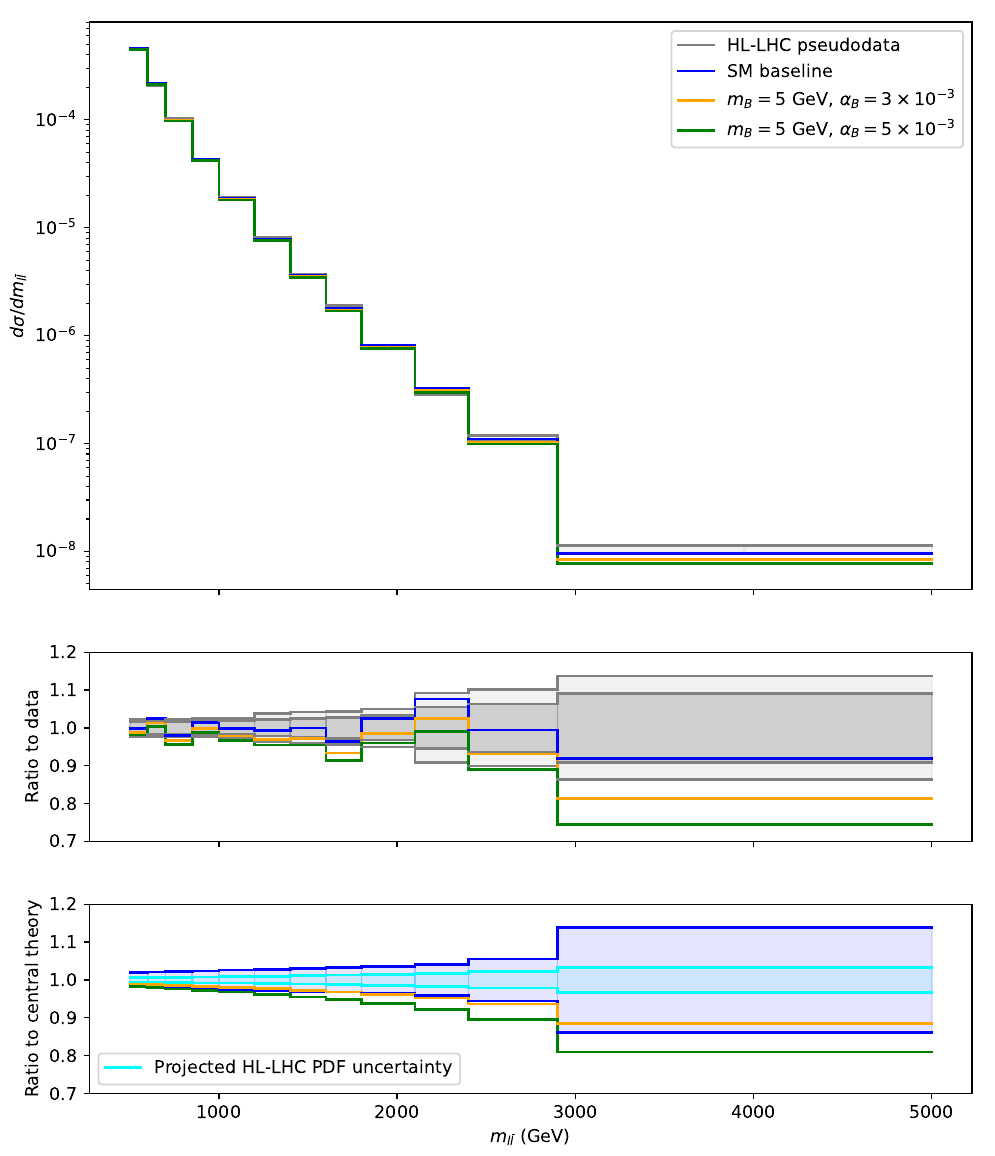
Figure 6 . Top: data-theory comparison between HL-LHC pseudodata in the electron channel generated according to eq. (3.7) (grey, with optimistic uncertainties displayed), and the theoretical predictions obtained using the NNLO baseline PDF set NNPDF3.1luxQED (blue) and those obtained using the dark PDF sets produced with parameters ( m ) = (5 GeV , 3 × 10 − 3 ) , (5 GeV , 5 × 10 − 3 ) B , α B (yellow, green respectively). Middle: ratio of the baseline SM central predictions obtained using the baseline, and the central predictions obtained using the two representative dark PDF sets, to the central values of the pseudodata. The relative experimental uncertainties in both the optimistic scenario (dark grey) and conservative scenario (light grey) are displayed. Bottom: ratio of the central predictions obtained using the two representative dark PDF sets to the baseline SM central predictions, with both the PDF uncertainty from the baseline PDF set (dark blue) and the projected PDF uncertainty at the HL-LHC in the optimistic scenario of [43] (light blue)